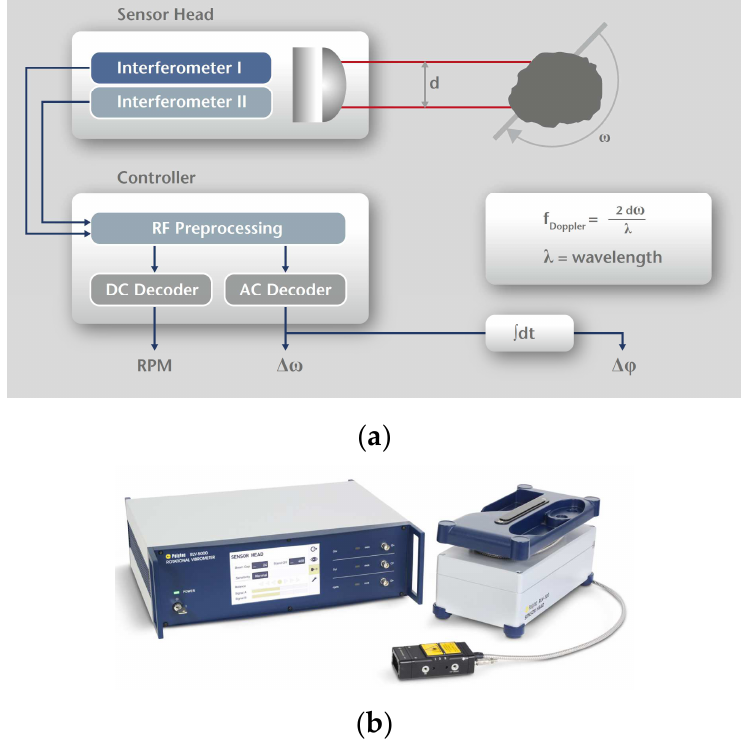
Figure 9. Visual representation of the processing of signals ( a ) using the Polytec RLV-5500 rotational laser vibrometer ( b )—see Figure 6, item No. 8 [72,73].